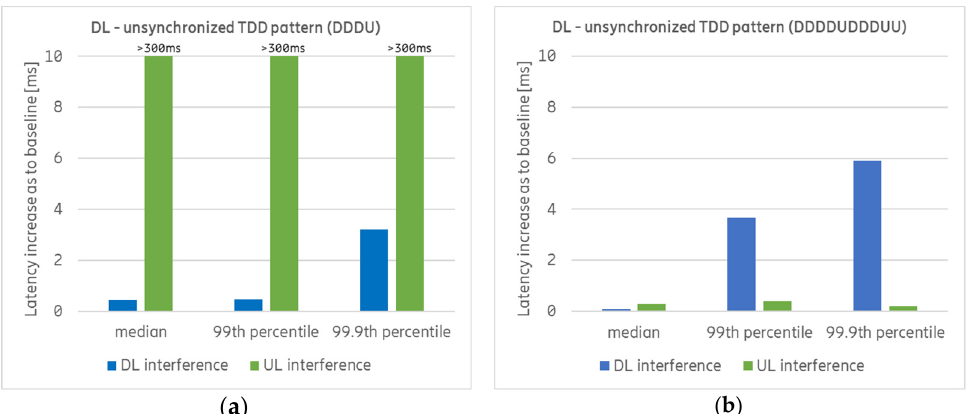
Figure 5. Increase in DL latency compared to its baseline for unsynchronized TDD pattern. ( a ) In- door TDD pattern DDDU and outdoors DDDDU are configured. ( b ) Indoor TDD pattern DDDDUDDDUU and outdoors DDDDU are configured.